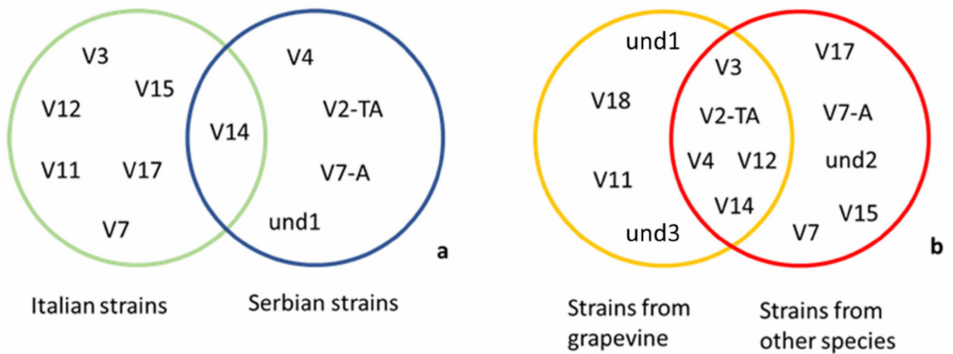
Figure 5. ( a ) Vmp1 -sharing Rsa I-V profiles between Italian and Serbian strains; ( b ) Vmp1 -sharing Rsa I-V profiles between ‘ Ca . P. solani’ strains from grapevine and from other host